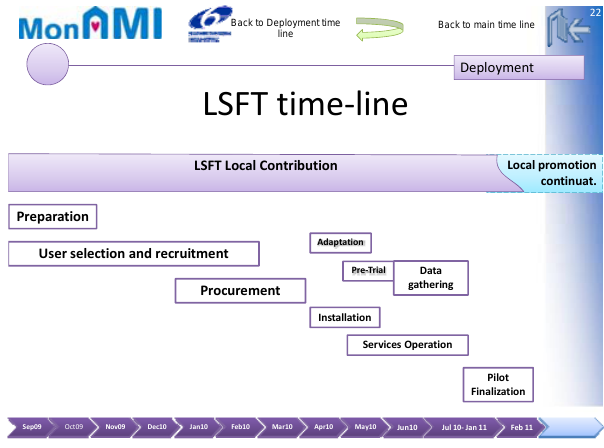
Figure 2. Demonstrator system implementation logistics in